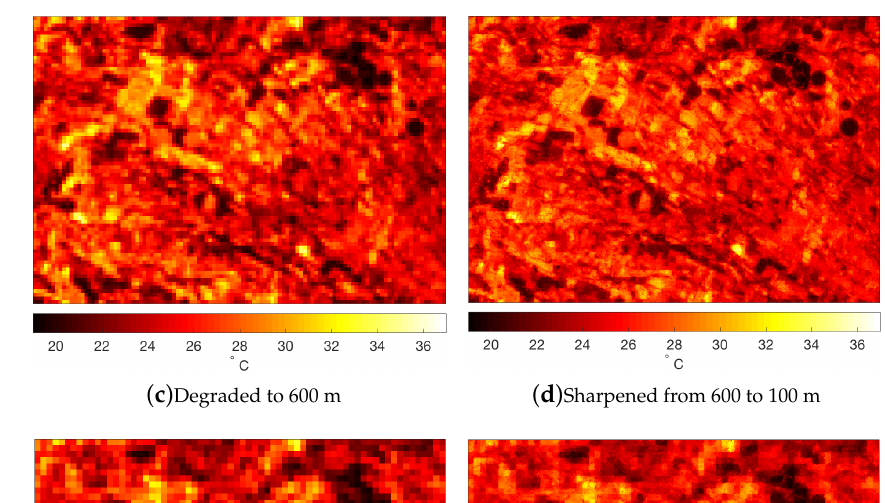
= 0.490 ◦ C and TS 2 uRF = 0.824 and the TS 2 uRF